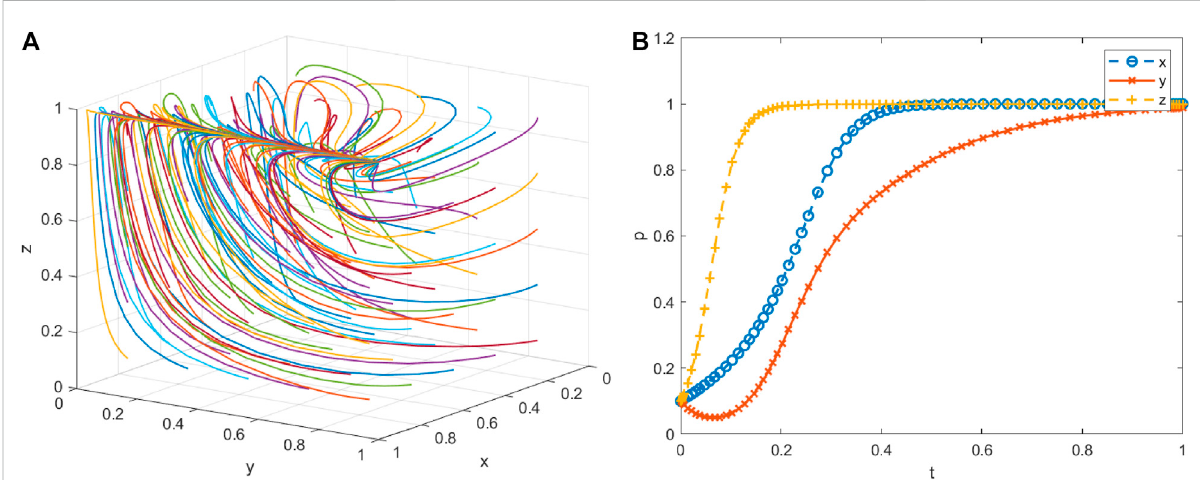
FIGURE 8 Simulation results of Scenario 7 evolution. (A) The three-dimensional phase diagram, which can show the evolution situation more clearly, and (B) The two-dimensional diagram, which can show the sensitivity of the game subject to the income more